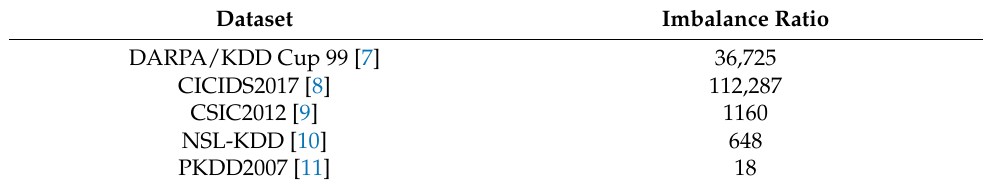
Table 1. Imbalance ratios of intrusion detection